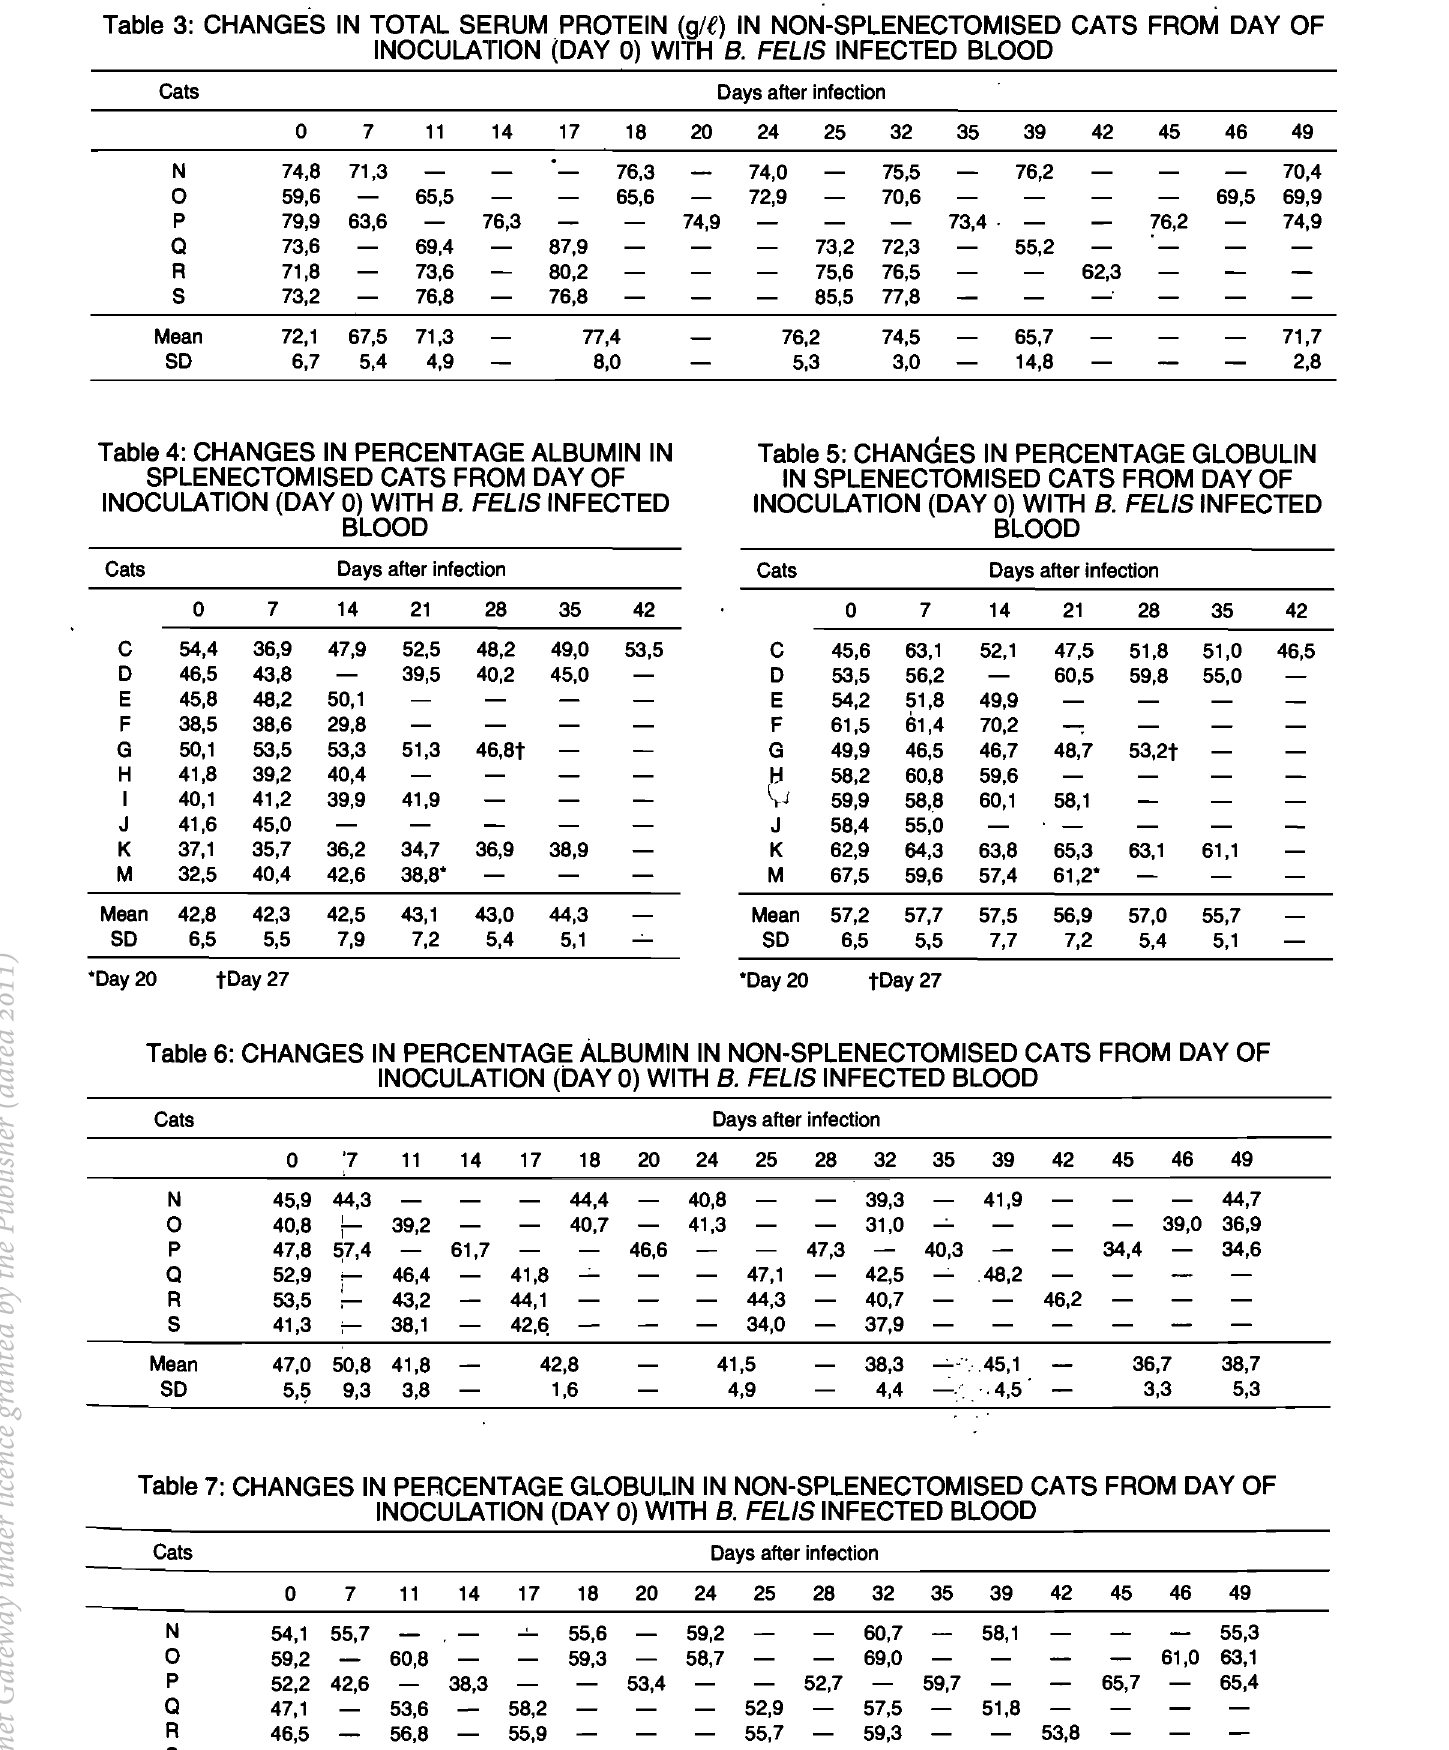
Table 3: CHANGES IN TOTAL SERUM PROTEIN (gft') IN NON-SPLENECTOMISED CATS FROM DAY OF INOCULATION (DAY 0) WITH B. FELIS INFECTED BLOOD